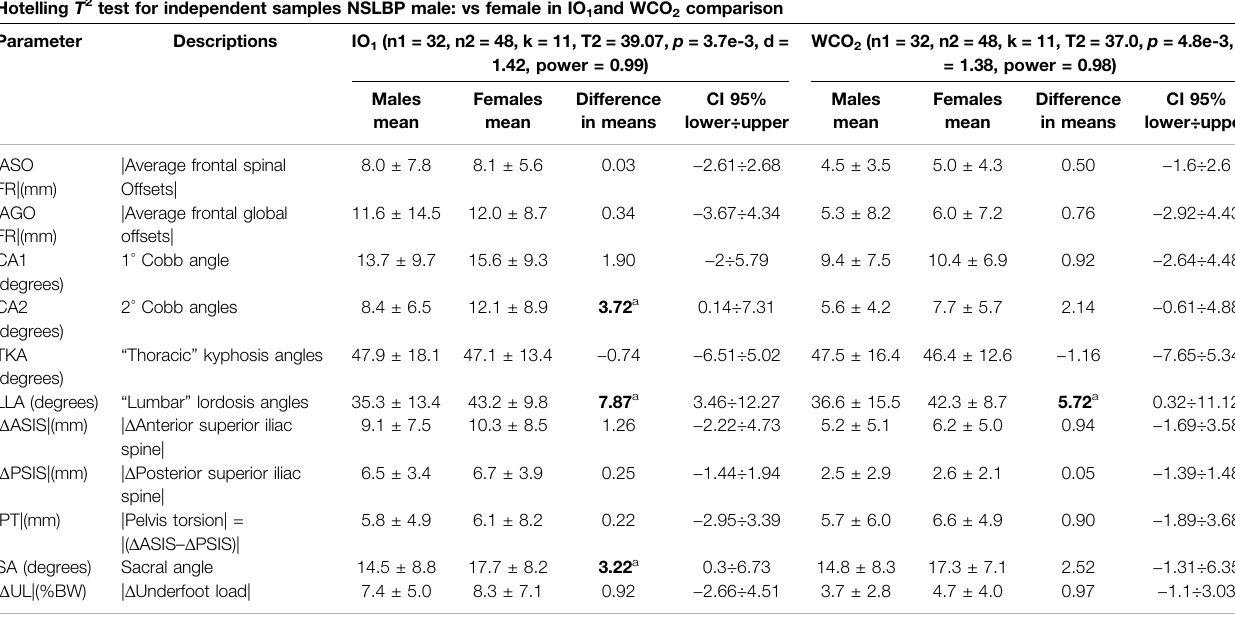
TABLE 3 | NSLBP Males vs. Females comparisons in IO 1 and WCO 2 : Hotelling T 2 tests results, 95% con fi dence intervals and difference of means. Hotelling T 2 test for independent samples NSLBP male: vs female in IO 1 and WCO 2